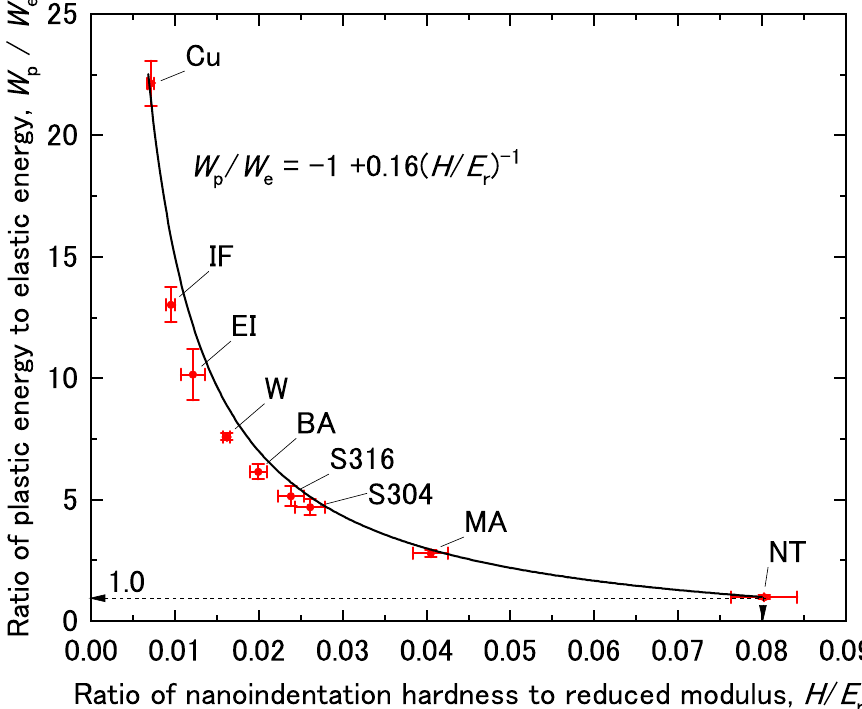
Figure 5. Ratio of plastic energy to elastic energy ( W p / W e ) as a function of nanoindentation hardness ( H ). The error bars are drawn with the standard deviation.